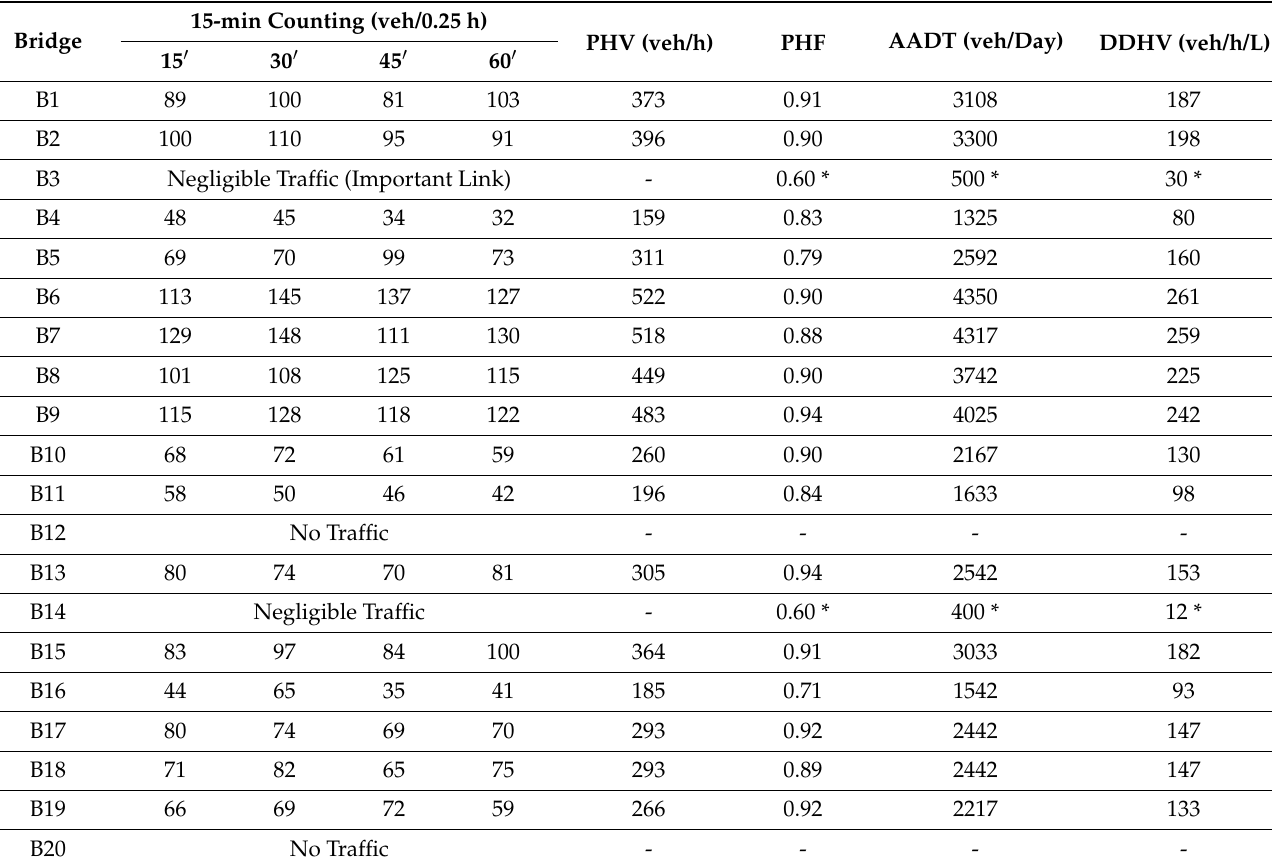
Table 4. Traffic flow for 1 h with 15 min